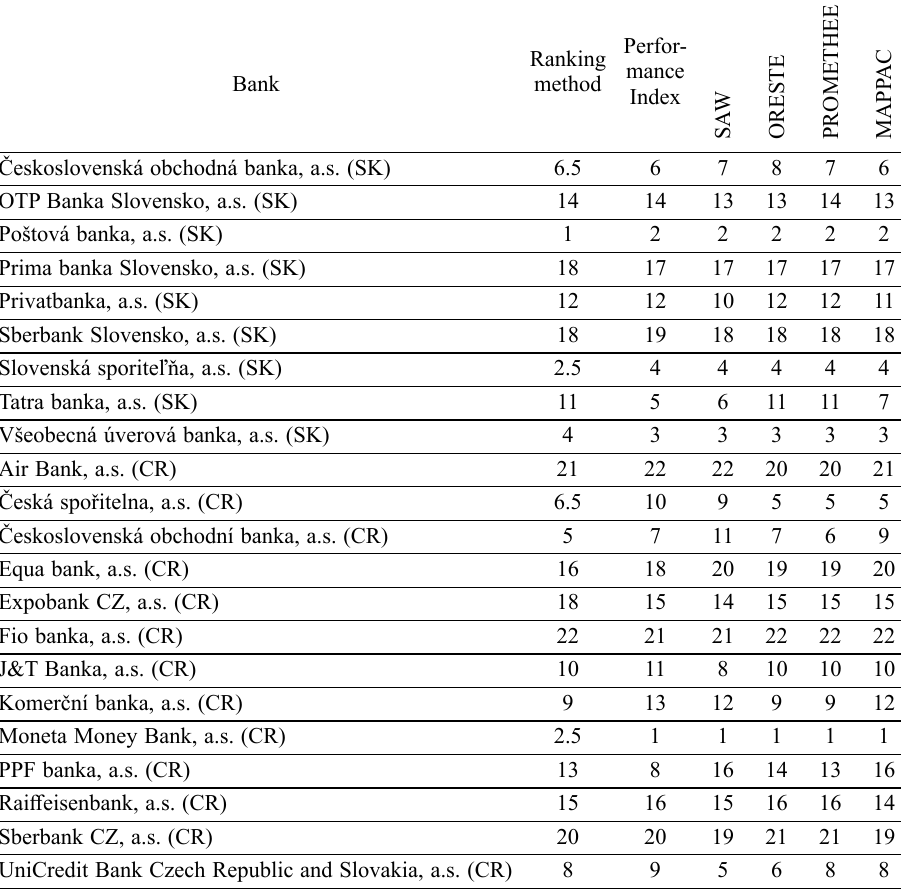
Perfor- mance Index